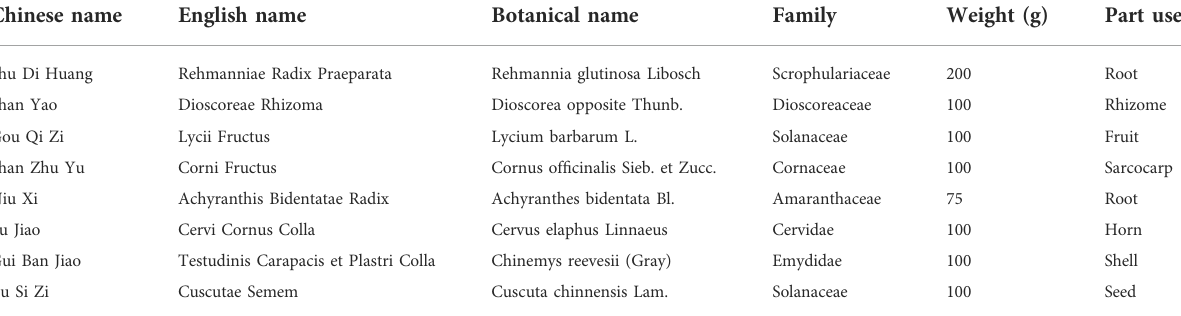
TABLE 1 Zuogui Wan ’ s